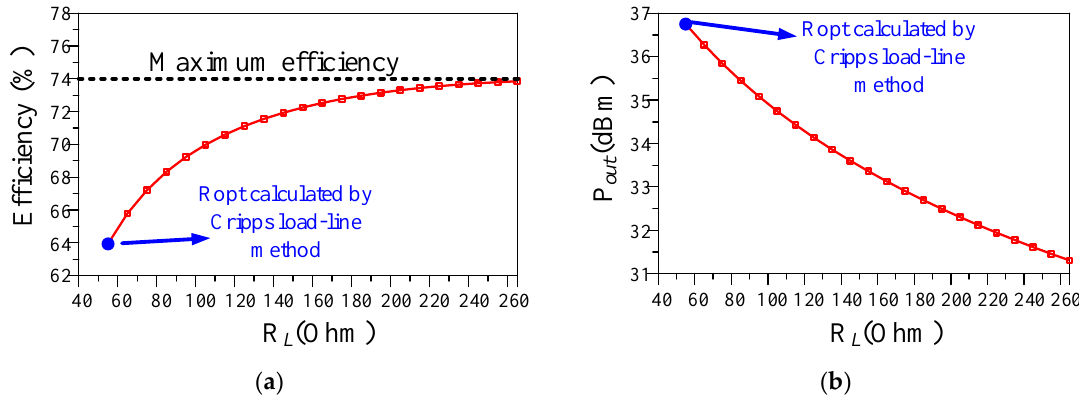
Figure 2. ( a ) Drain efficiency and ( b ) output power of the 8 × 100 μm FET calculated using the Pedro load-line method.